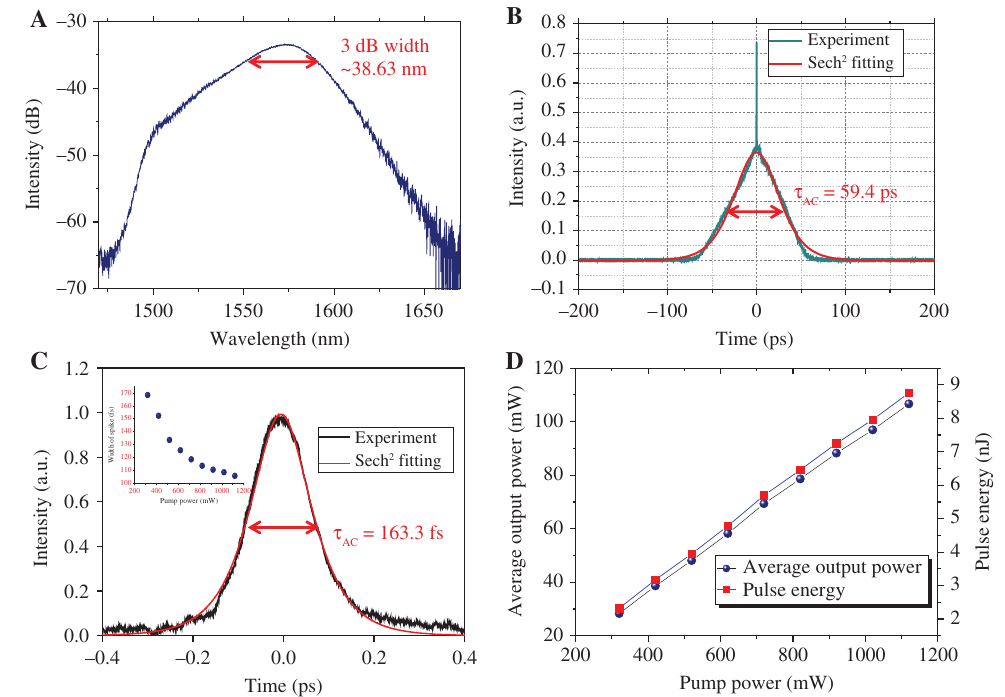
Figure 10: Output characteristics of tellurene-based SA NLP operation under the maximum pump power of 1120 mW. (A) Emission optical spectrum with wide 3 dB spectrum width. (B) Measured autocorrelation trace of the pulse. (C) Measured and fitted autocorrelation traces of the spike. (Inset of C) Relationship between the spike width and pump power. (D) Out average output powers and pulse energies under different pump